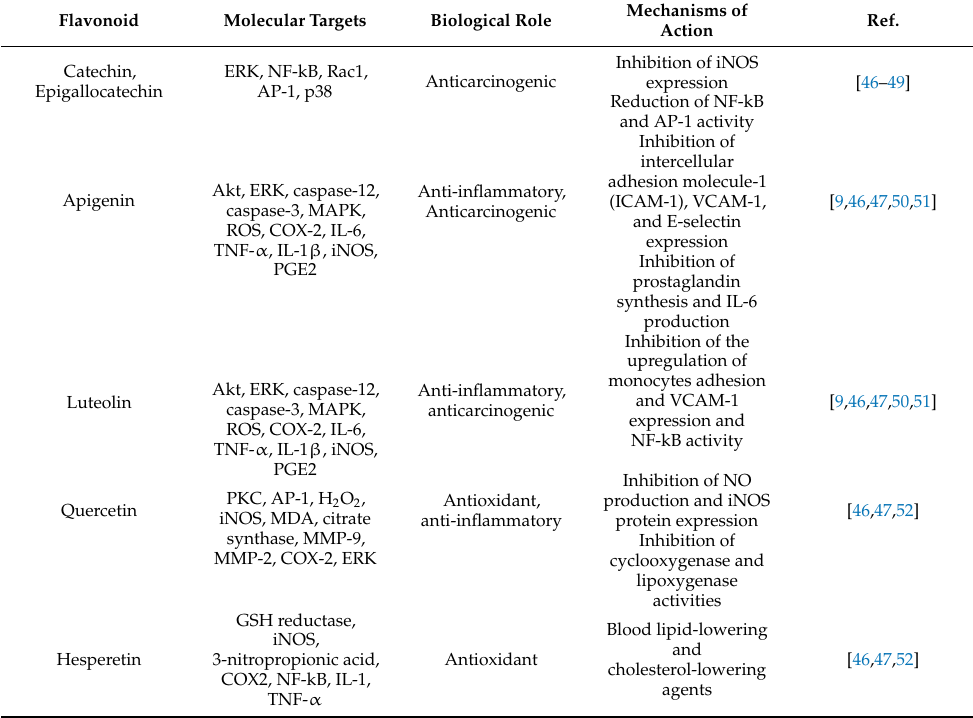
Table 2. Synopsis of the main molecular targets and mechanisms of action of